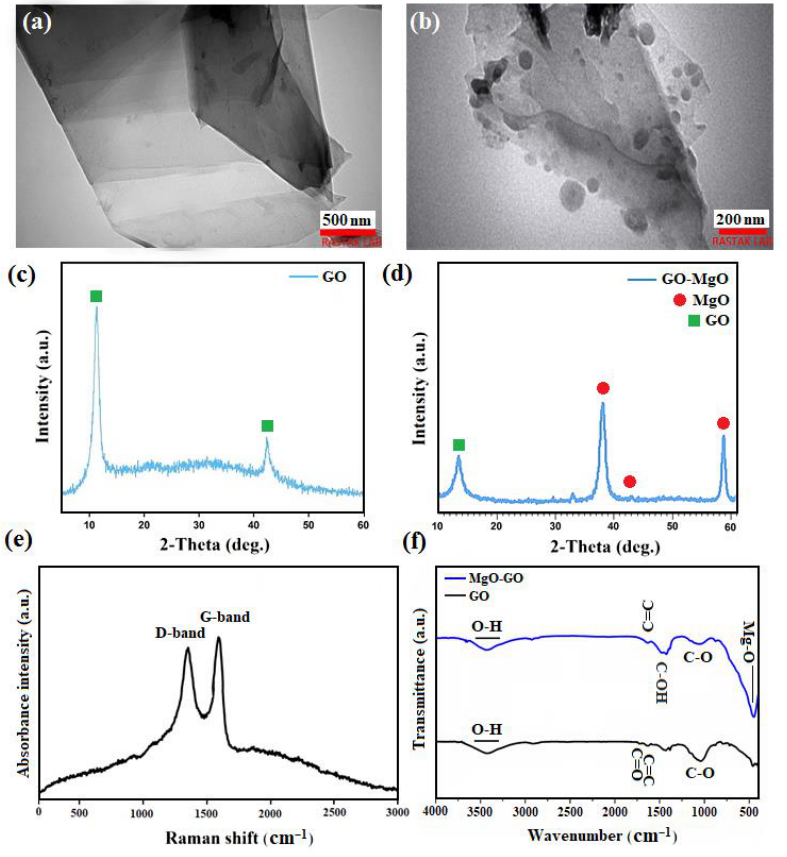
Figure 1. Transmission Electron Microscopy (TEM) images of ( a ) GO, ( b ) MgO/GO powders; X-ray Fig. 1 Diffraction (XRD) patterns of ( c ) GO and ( d ) MgO-GO powders; and ( e ) Raman spectra of GO and ( f ) Fourier Transform Infrared (FTIR) patterns of GO and MgO-GO powders.